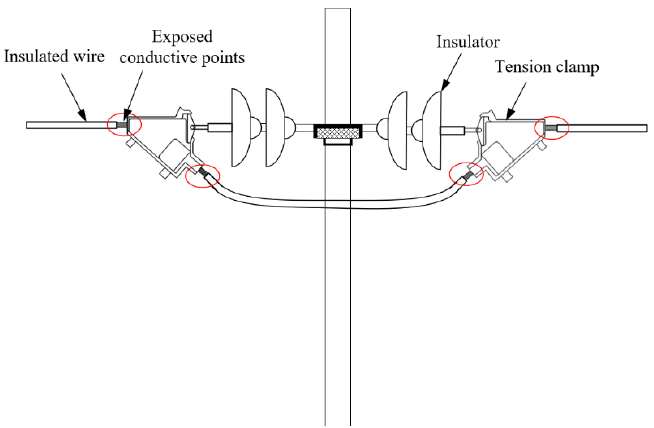
Figure 1. Exposed conductive points in a power grid.